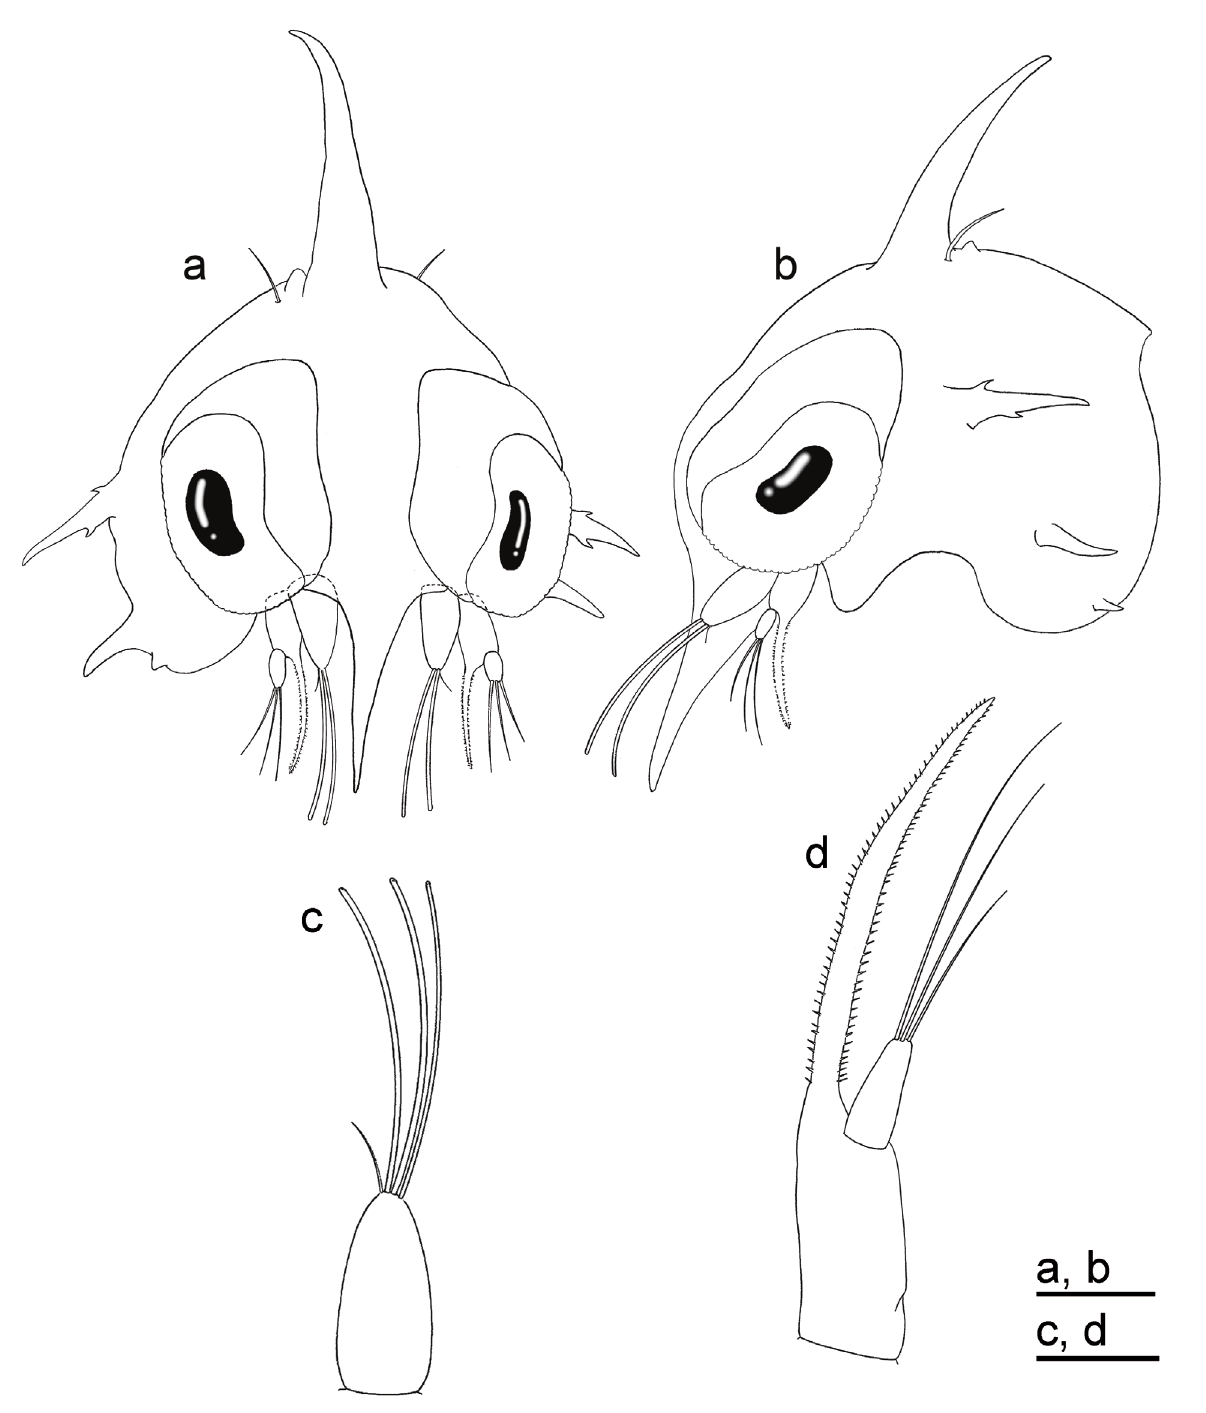
Figure 1. Domecia acanthophora (Desbonne, in Desbonne & Schramm, 1867), Zoea I. a. Cephalothorax, frontal view; b. Cephalothorax, lateral view; c. Antennule; d. Antenna (scale bars: a, b = 0.1 mm; c, d = 0.05